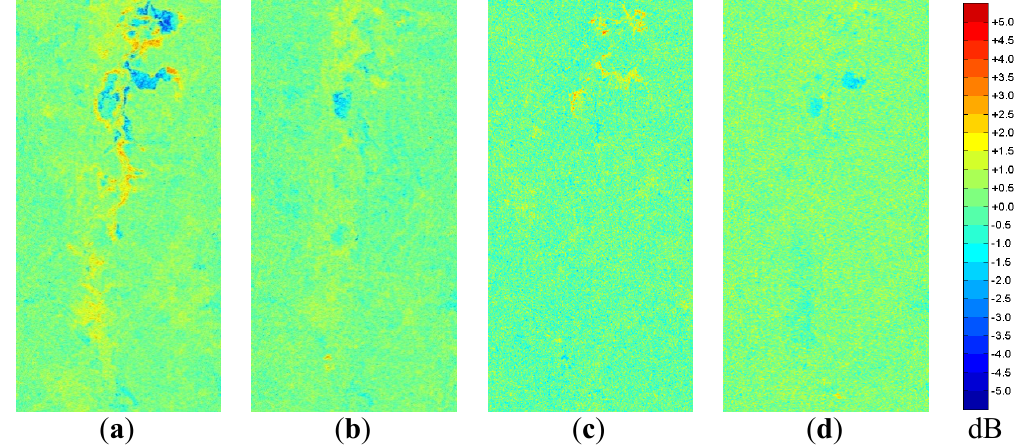
Figure 12. Change in Kennaugh Element k acquisitions scaled in decibel: ( a ) April to May; ( b ) May to June; ( c ) June to July; and ( d ) July to August.